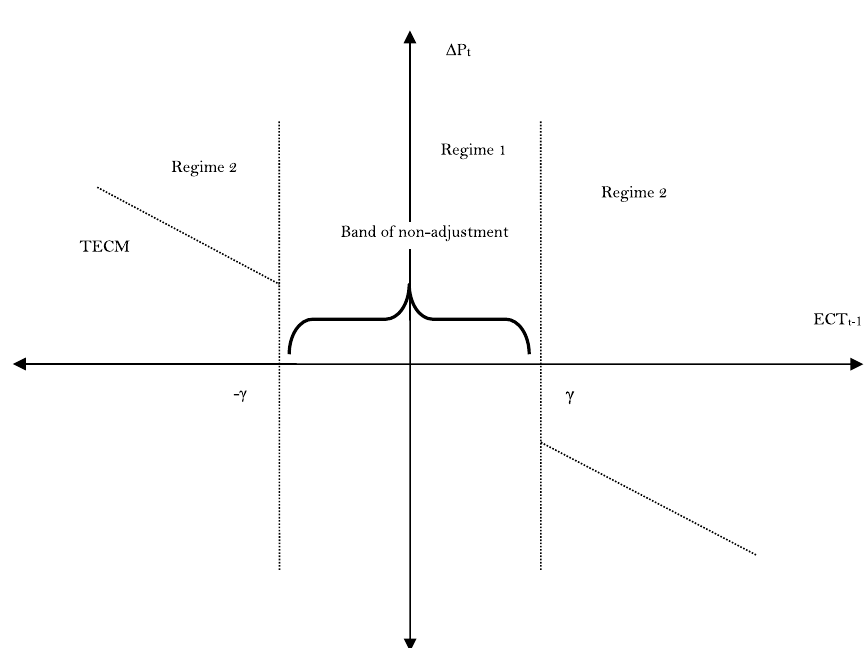
Fig. 1 Effect of transaction costs in the price